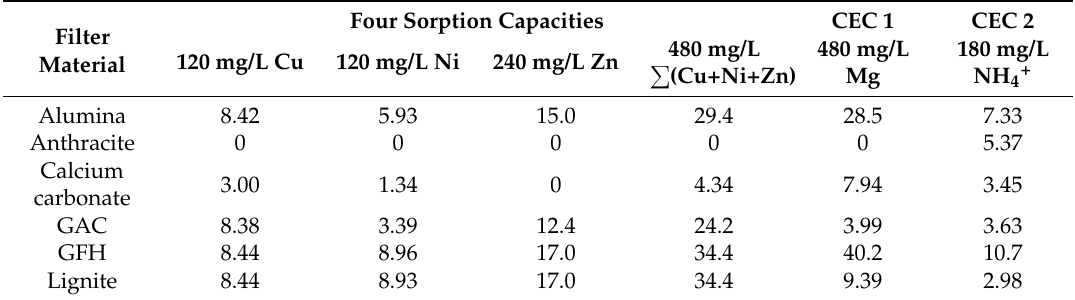
Table 3. Comparison of different capacities determined by batch experiments at pH 5 with the rotary shaker and without a buffer, CEC 1, and CEC 2—all values in cmol +